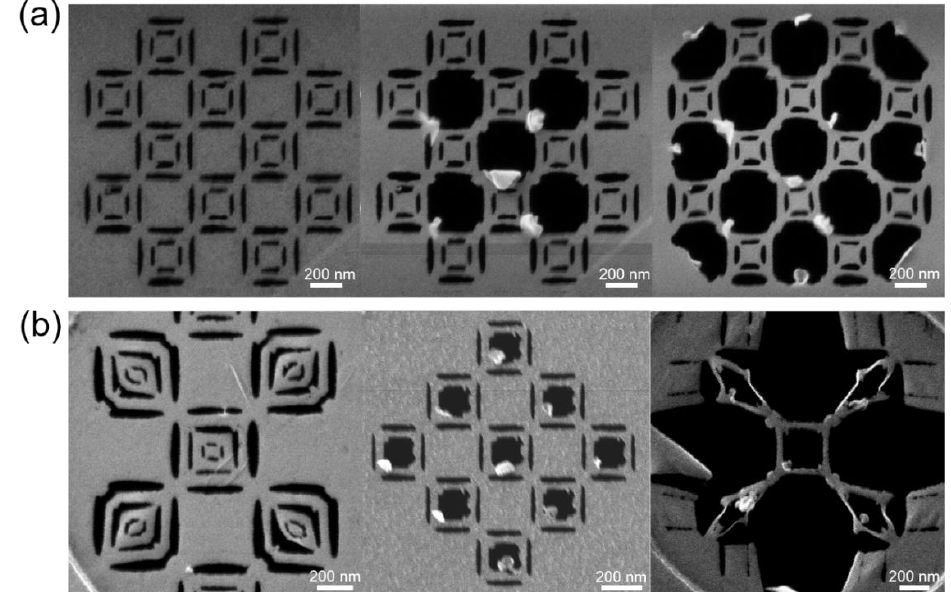
Figure 7 . Complex features patterned under base parameters. ( a ) demonstrates a progressive milling procedure for a kirigami pattern and ( b ) shows several other compete patterns. With designed CAD files, these nanoscale graphene kirigami patterns can be easily realized by laser-assisted He + milling. The suspended structures are stable with these graphene bridges with the width of tens of nanometers.